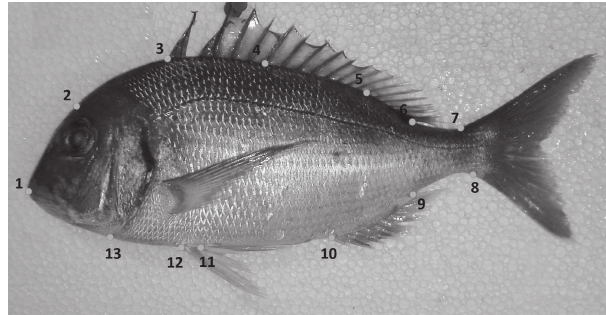
Fig. 2. Location of the 13 anatomical landmarks of Pagrus pagrus : (1) anterior tip of the snout, (2) dorsal surface of the head at the nearest point to the eye globe, (3) origin of the dorsal fin, (4) 8th ray of the dorsal fin, (5) 16th ray of the dorsal fin, (6) posterior end of the dorsal fin, (7) dorsal origin of the caudal fin, (8) ventral origin of the caudal fin, (9) insertion of the anal fin, (10) origin of the anal fin, (11) insertion of the pelvic fin, (12) origin of the pelvic fin, (13) posterior insertion of the sub-operculum.